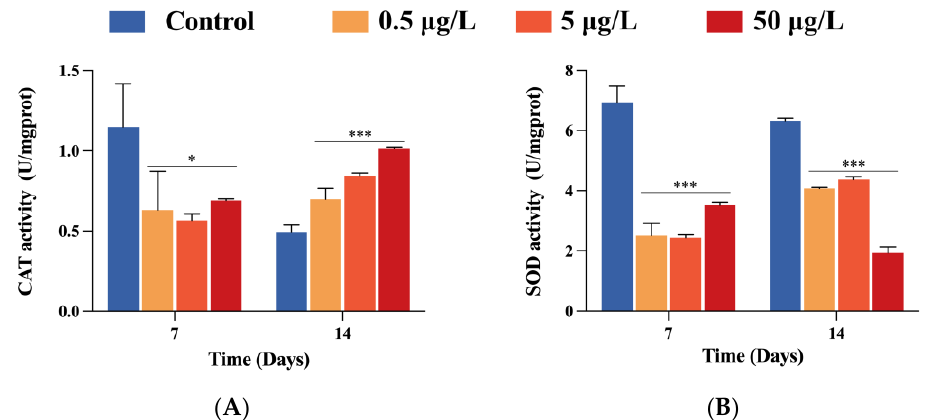
Figure 4. Effects of FF-exposure on the activity of CAT ( A ) and SOD ( B ). Bars represent the mean ± SEM (n = 5). The asterisks “*” indicate statistical significance compared to the control group (* p < 0.05 and *** p < 0.001).